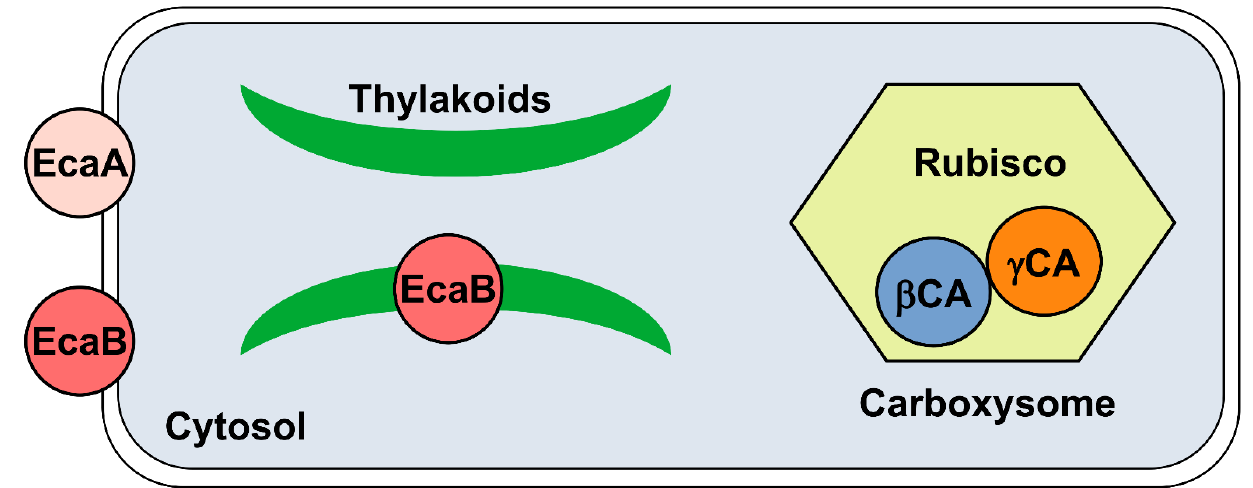
Figure 7. Schematic picture of cyanobacterium cell, highlighting the presence of the carboxysome and thylakoid membranes within the cytosol. Subcellular localization of CAs is also shown: EcaA ( α -CA) is extracellular, EcaB (β -CA) is primarily located in the thylakoid membrane with a smaller component associated with the plasma membrane, and β - and γ -CAs are localized in the carboxy- some.